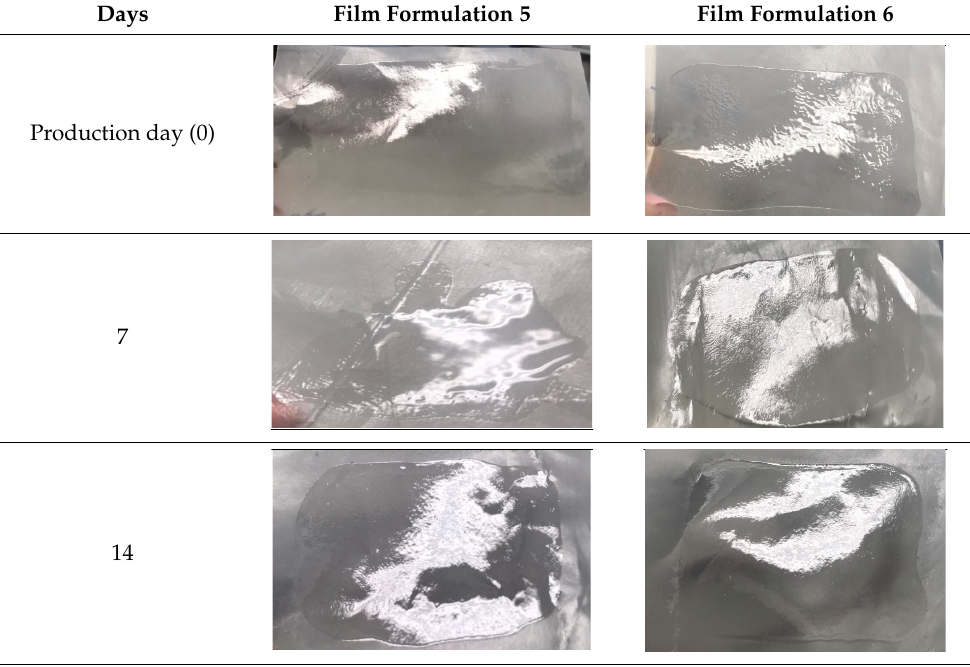
Table 4. The stability test for films No. 5 and No. 6.